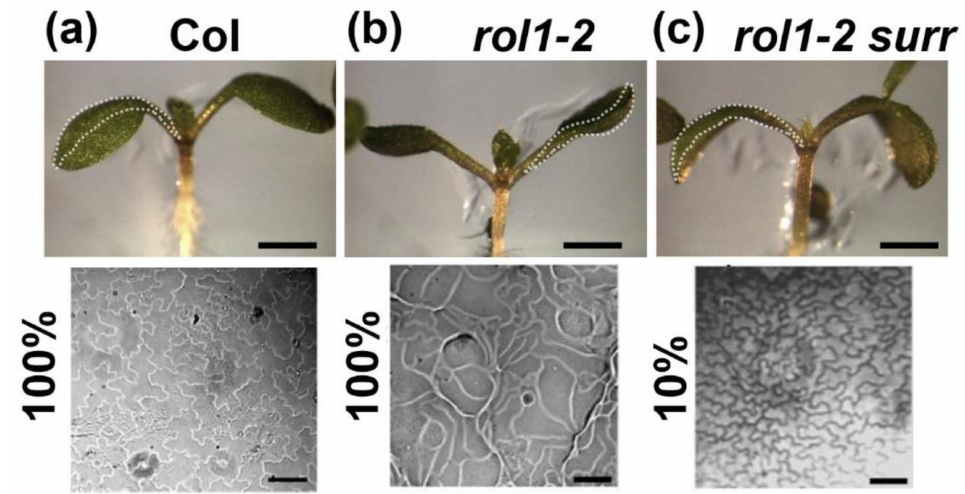
Figure 4. rol1-2 shoot phenotypes are partially suppressed in rol1-2 surr . Seedlings were grown for 6 days and a representative picture of the shoot on side-view was taken (upper row). The bending of the cotyledons is indicated with a stippled line for better visualization. Epinastic cotyledons formed in the wild type ( a ) and the rol1-2 surr double mutant ( c ), whereas rol1-2 formed hyponastic cotyledons ( b ). The lower row shows pavement cell shapes of the adaxial side of cotyledons. Jigsaw puzzle-like cell shapes are typical for the wild type, whereas the lobing is not found in the rol1-2 . Only 10% of all cotyledons of rol1-2 surr mutants show re-establishment of the lobing as shown in ( c ); in 90% of the cases, they develop rol1-2 -like cell shapes. Barv = 1 mm (upper row), 40 µ m (lower